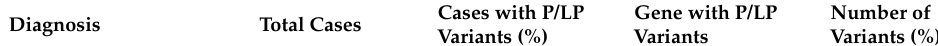
Table 2. Clinical characteristics and frequency of P/LP variants among tested